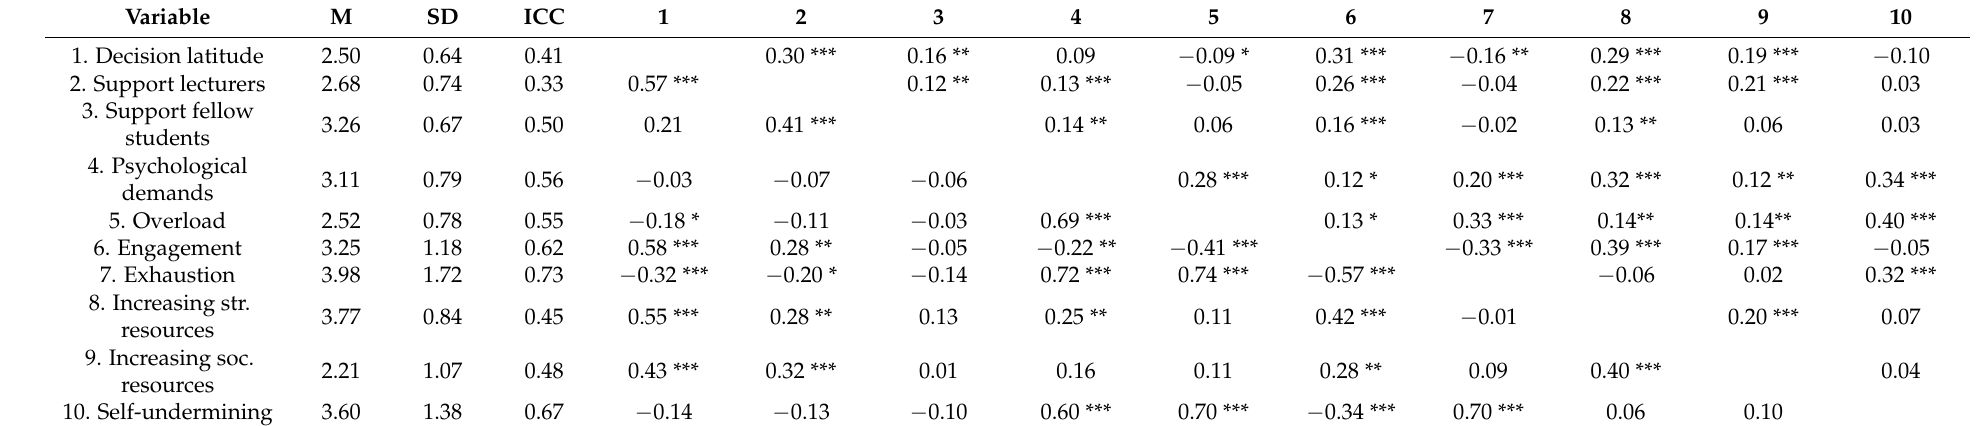
Table 1. Means, standard deviations, ICCs, and intercorrelations of all study